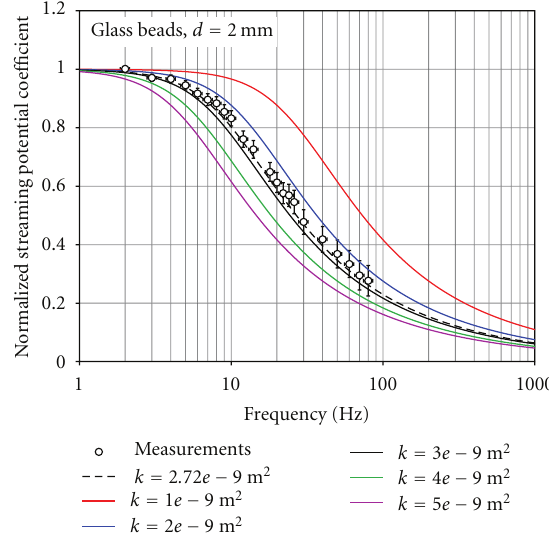
Figure 8: The calculated streaming potential coupling coe ffi cient (normalised to the value at 2Hz, which was 1.80 V/MPa) as a function of frequency using the Pride model [23] for a pack of nominally 2mm diameter glass beads saturated with 10 − 3 mol/L NaCl solution at 24 ◦ C ( φ = 0 . 382, κ D C = 27 . 2 × 10 − 10 m 2 ). Each solid curve shows the results of the model for a di ff erent value of permeability. The dashed line is for the permeability of the sample that was measured